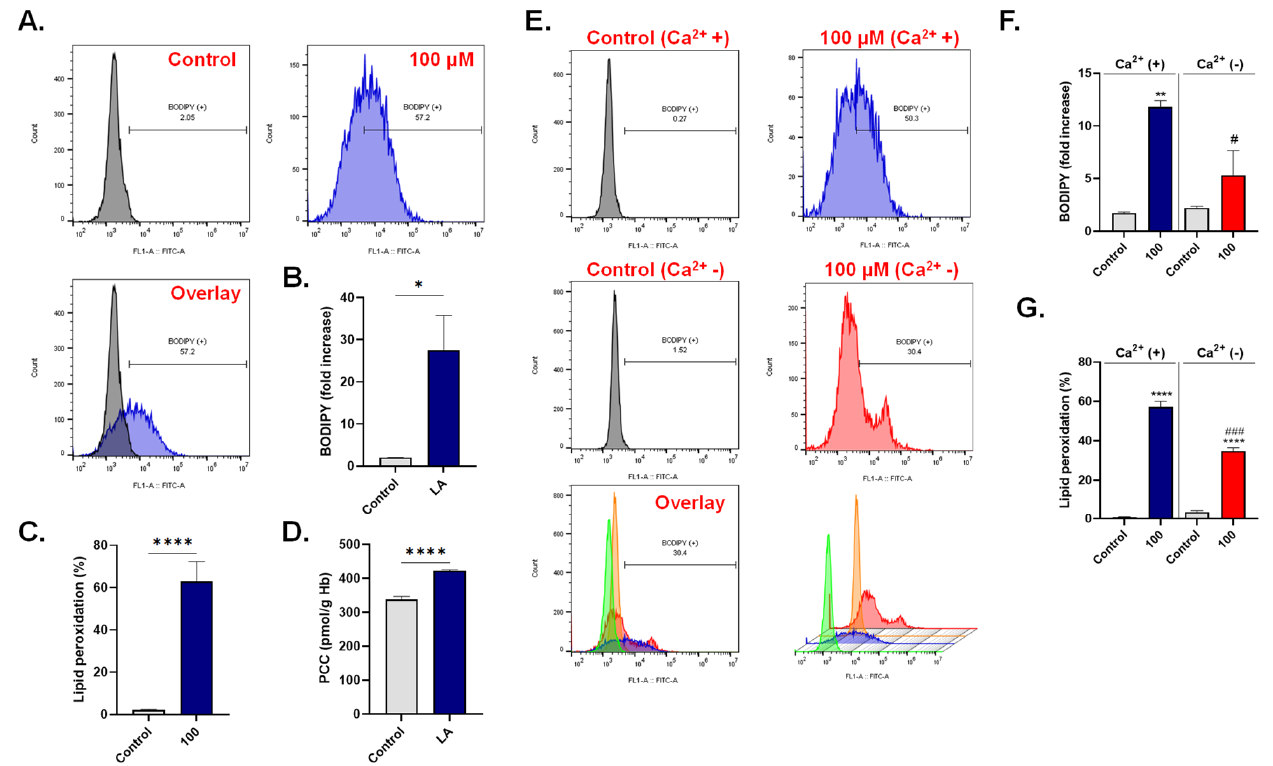
Figure 7. LA triggers Ca 2+ -dependent lipid peroxidation and protein carbonylation. ( A ) Representative histograms of BODIPY fluorescence of cells exposed to 0–100 µ M of LA. ( B ) LA-induced fold increase in MFI of BODIPY. ( C ) LA-induced increase in the percentage of cells with high lipid peroxides. ( D ) PCC content in cells exposed to 0 or 100 μ M of LA. ( E ) Representative histograms of BODIPY fluorescence of cells exposed to 0–100 μ M of LA in presence or absence of Ca 2+ . ( F ) LA-induced BODIPY fold increase with and without Ca 2+ . ( G ) LA-induced increase in the percentage of cells with high lipid peroxides with and without Ca 2+ . * ( p < 0.05), ** ( p < 0.01), and **** ( p < 0.0001) indicate significantly different values from control conditions whereas # ( p < 0.05) and ### ( p < 0.001) indicate statistical significance compared to LA-treated cells